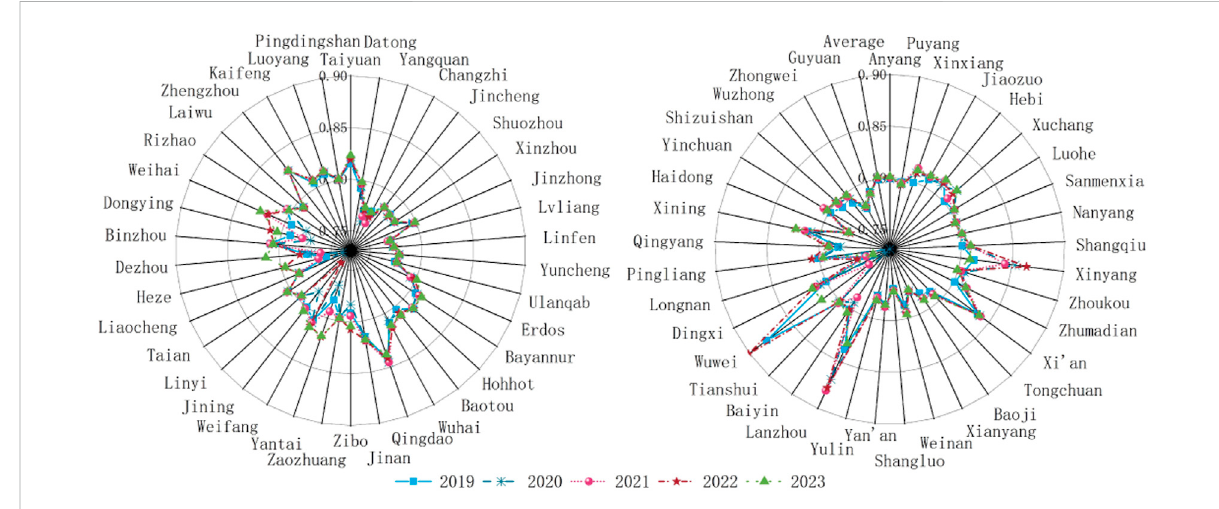
FIGURE 4 Future development trend chart of coupled coordination values in the Yellow River